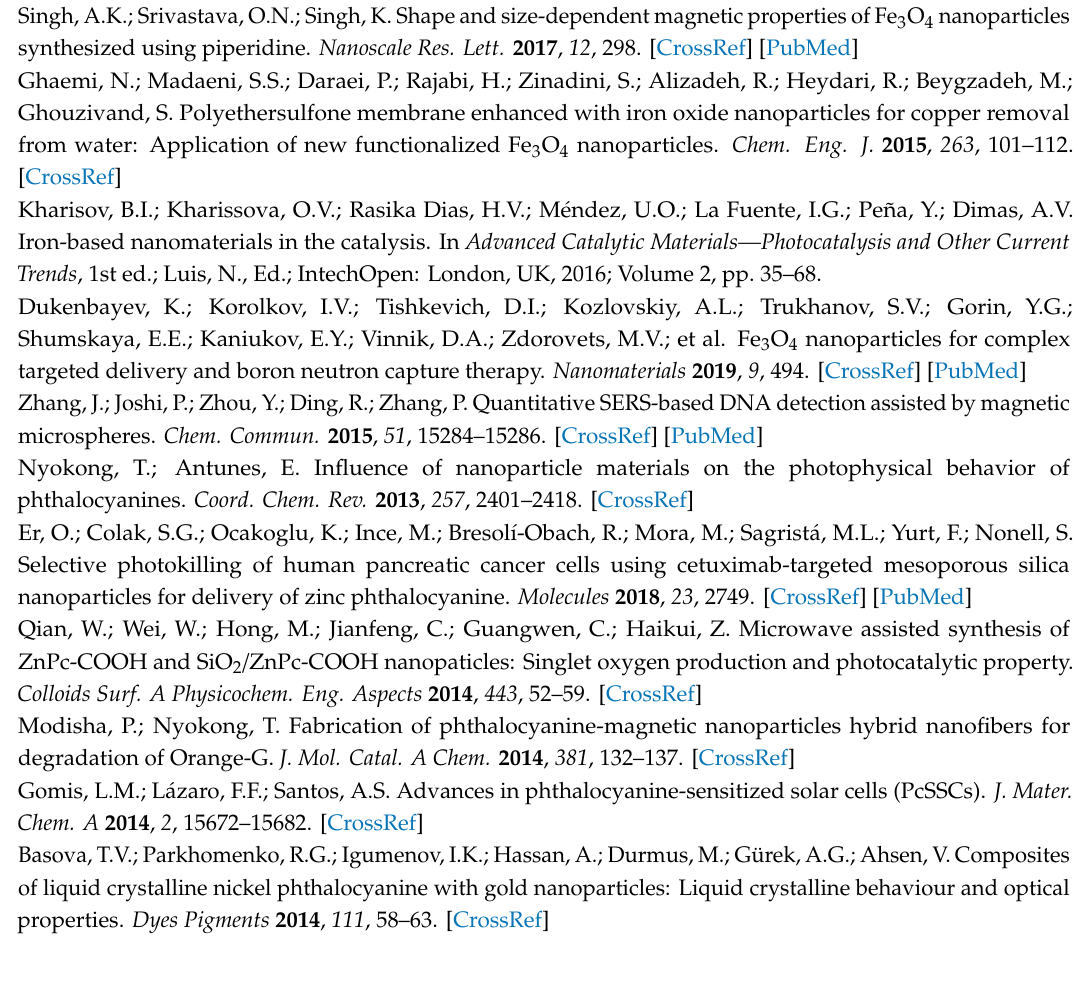
Figure S1: 13 C NMR (300 MHz, CDCl 3 ) of the (a) Pc, (b) CoPc, (c) CuPc, (d) NiPc and (e) ZnPc, Figure S2: 1 H NMR (300 MHz, CDCl 3 ) of the (a) Pc, (b) CoPc, (c) CuPc, (d) NiPc and (e) ZnPc, Figure S3: Mass Spectra (MALDI-TOF-MS) of the (a) Pc, (b) CuPc, (c) NiPc, (d) ZnPc and (e)